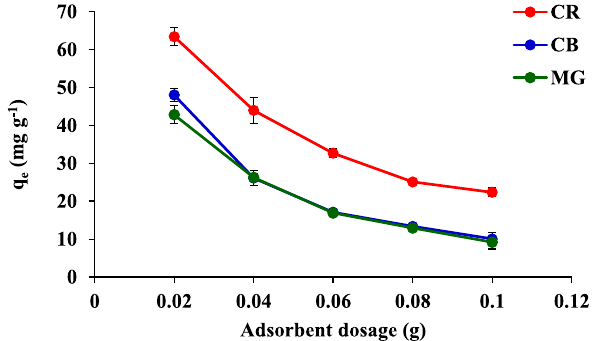
Figure 6. Effect of the adsorbent dose on the adsorption of CR, CB, and MG.